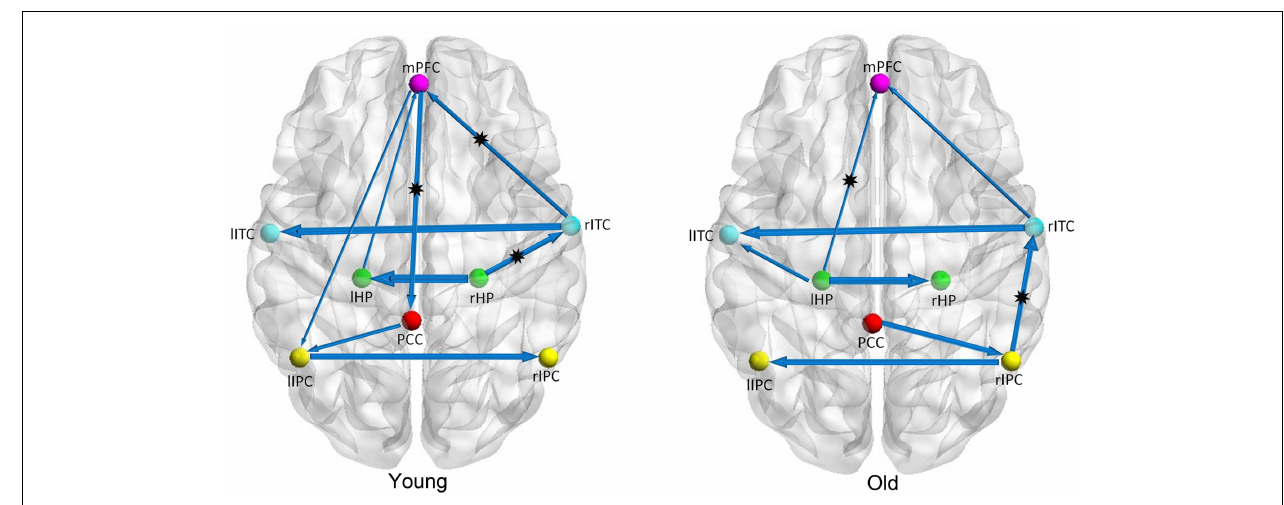
proportional to the strength of the connections.The asterisks indicate the connections that were significantly stronger in young/old than in old/young groups.